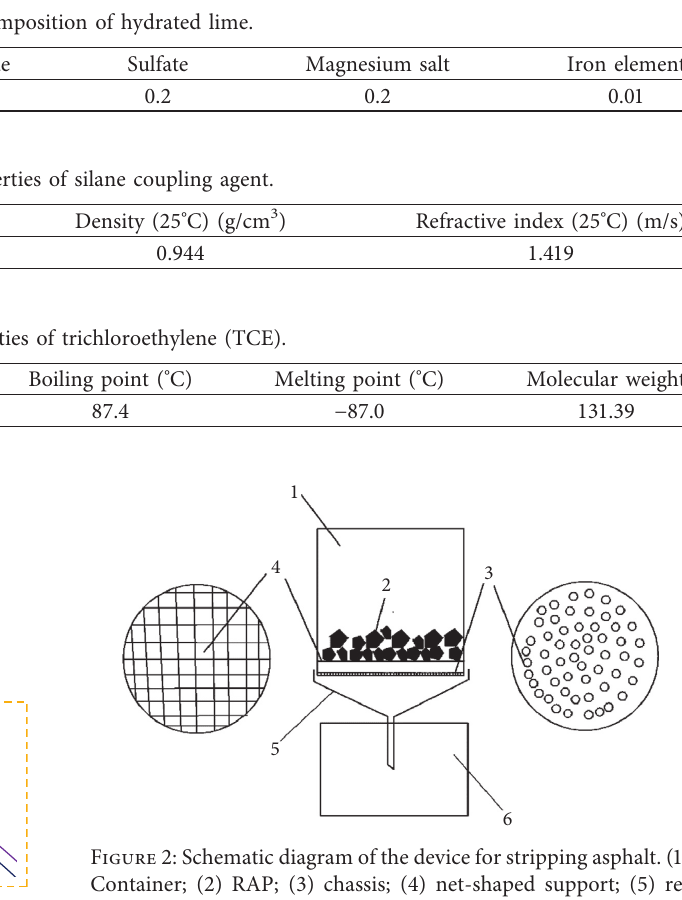
Figure 1: Schematic diagram of asphalt layers on the RAP surface.